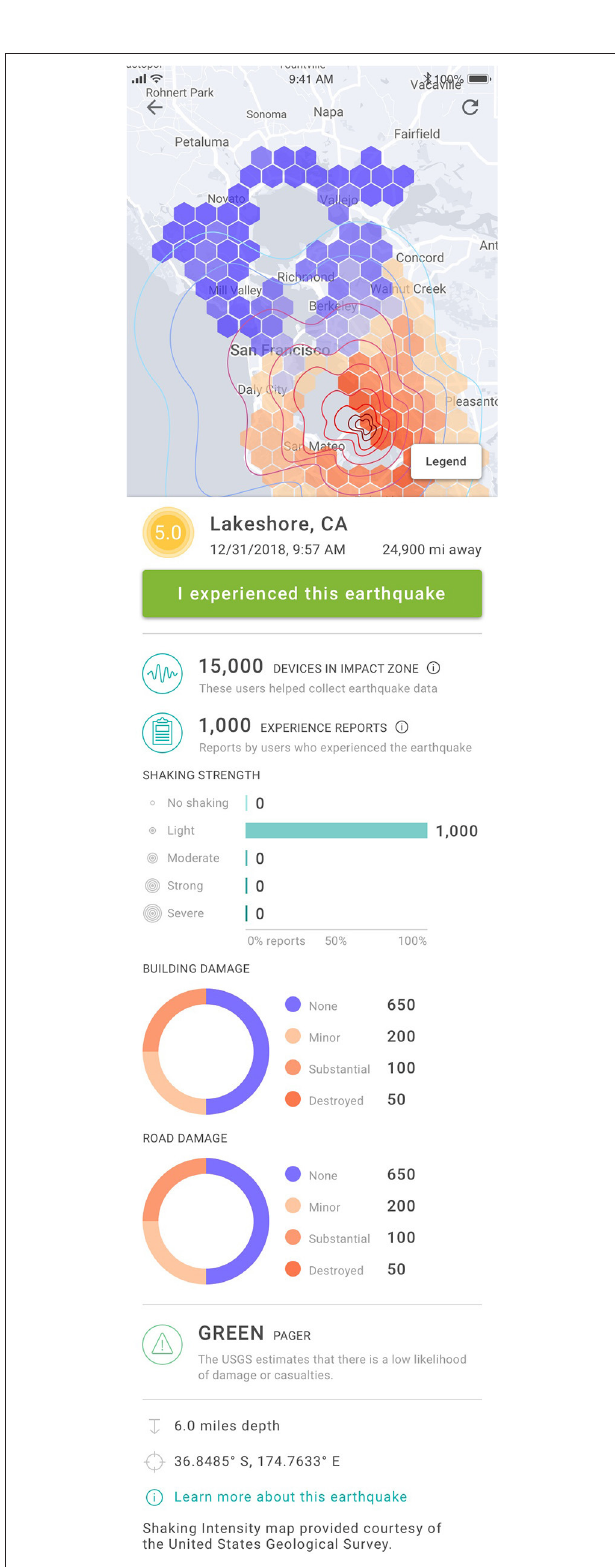
FIGURE 10 | Earthquake Details page with sample user data to show how hexbins and data visualizations would present user Experience Report data.